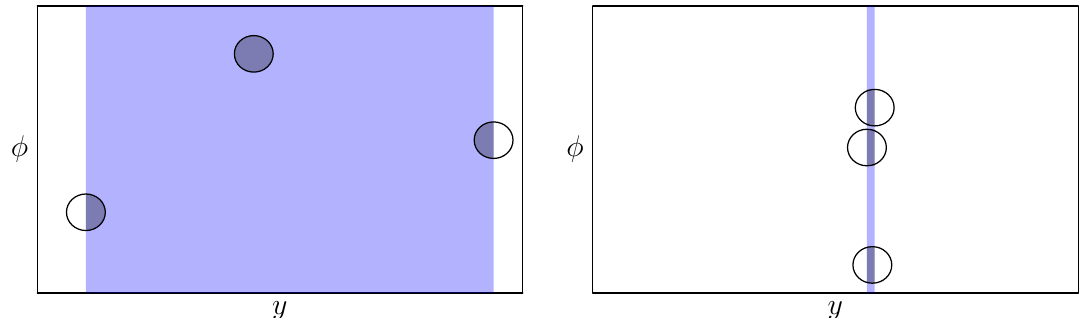
Figure 4. Estimated phase space areas for the emission of extra gluons for sample three-jet con(cid:12)gurations. The left panel shows the case of a large rapidity separation. On the right we illustrate the estimate for a very small rapidity span.